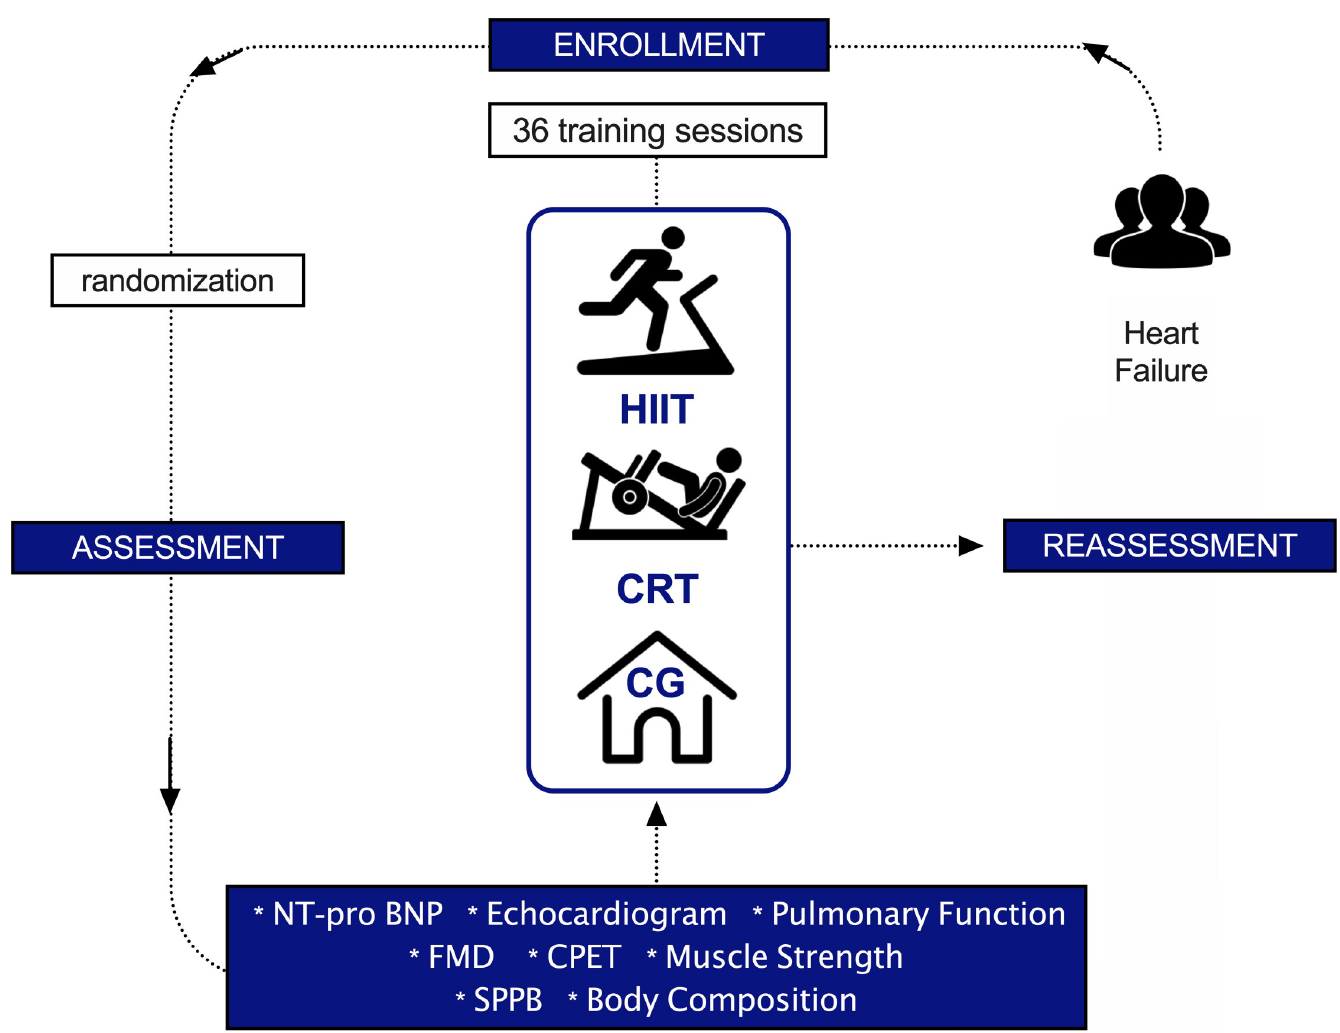
Fig 2. Study design. Study overview flowchart. HIIT, high-intensity interval training; CRT, circuit-resistance training; CG, control group; NT-pro BNP, N-terminal pro-brain natriuretic peptide; FMD, flow-mediated dilatation; CPET, cardiopulmonary exercise test; SPPB, Short Physical Performance Battery.